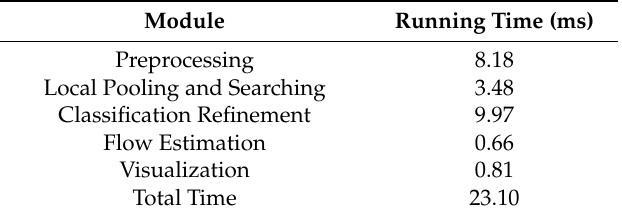
Table 9. The average running time result of each module of the proposed